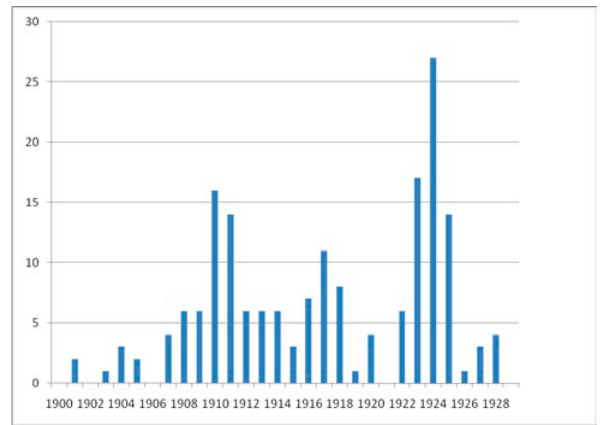
Figure 2. Auer von Welsbach – correspondence with chemists and physicists in Europe. Source 14 : Gerd Löffler, Carl Auer von Wels- bach und sein Beitrag zur frühen Radioaktivitätsforschung und Quantentheorie , ISBN 978-3-200-04400-5 , 2015 , p. 127,